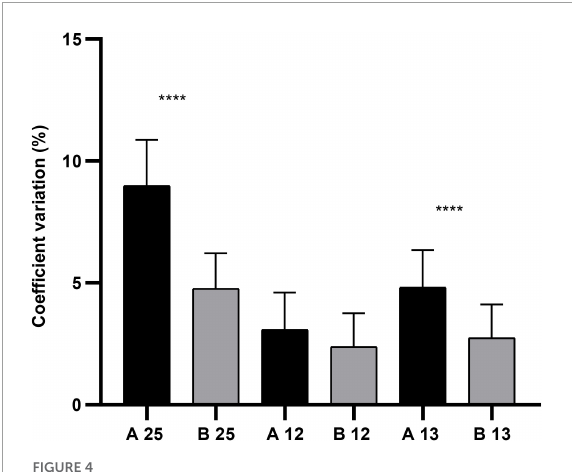
FIGURE4 The comparison of CV25, CV13, and CV12 in Group A ( n = 22) and Group B ( n = 22), **** meant P < 0.001.